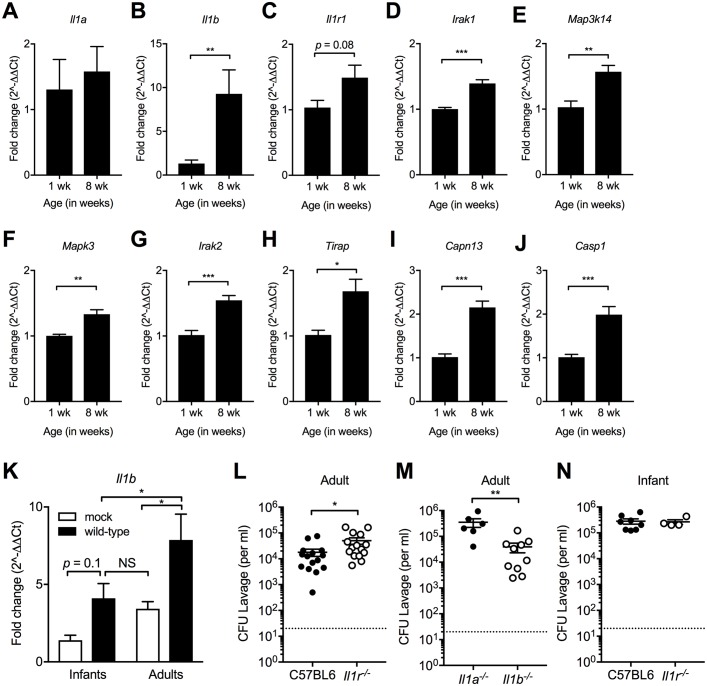
Repressed IL-1 signaling in infants.Five uninfected pups aged 1 week (Infant Mock) and five uninfected adults aged 8 weeks (Adult Mock) received RLT lavages from which RNA was subjected to qRT-PCR analysis. (A-J) Expression of (A) Il1a, (B) Il1b, (C) Il1r1, (D) Irak1, (E) Map3k14, (F) Mapk3, (G) Irak2, (H) Tirap, (I) Capn13, and (J) Casp1 by qRT-PCR was calculated as fold change in uninfected adults (aged 8 weeks) as compared to uninfected infants (aged 1 week). (K) Il1b expression in uninfected (mock) and serotype 23F infected infants and adults calculated as fold-change compared to mock-infected infants. (L-N) Serotype 23F i.n. colonization of (L) C57BL6 and Il1r-/- and (M) Il1a-/- and Il1b-/- adult mice (aged 8 weeks) and (N) C57BL6 and Il1r-/- pups (aged 1 week). Pneumococcal colonization density in adult and infant URT was determined 3 days post-inoculation. Groups represent n = 4–15 animals with mean ±SEM. Significance is indicated by *, P < 0.05; **, P < 0.01.